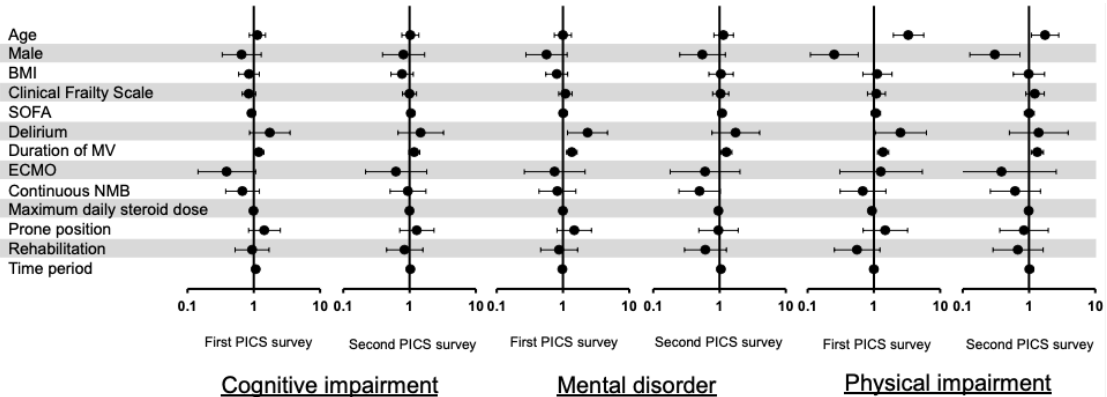
Figure 5. Risk factors for three elements of PICS. The results of multiple logistic regression analysis of cognitive impairment, mental disorder, and physical impairment are shown in a forest plot. Age